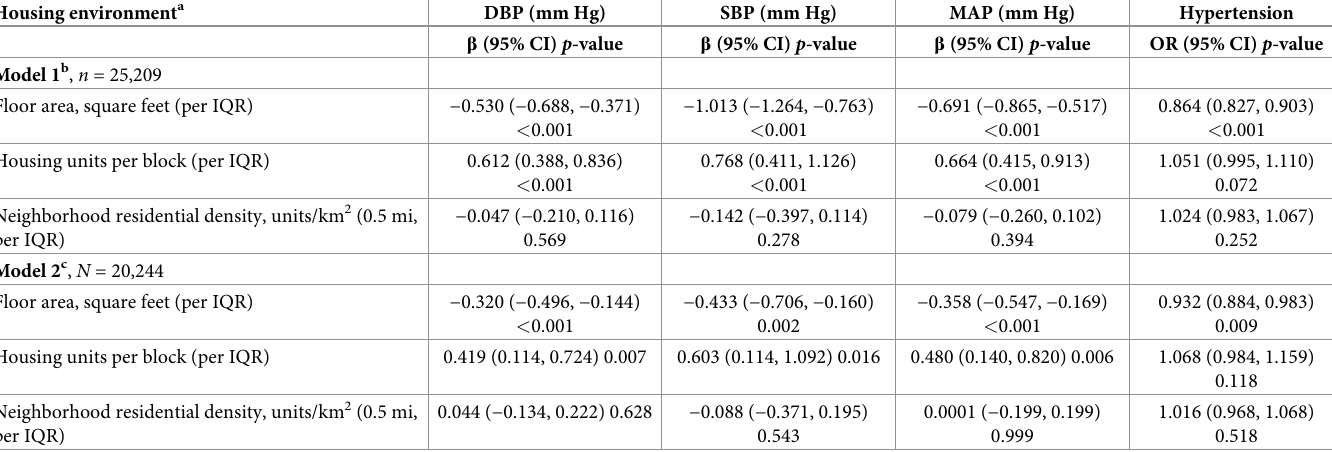
Table 3. Cross-sectional association of housing environment exposures with measures of blood pressure outcomes and prevalent hypertension among FAMILY Cohort participants aged 16 or above in the first follow-up (wave 2). Housing environment a